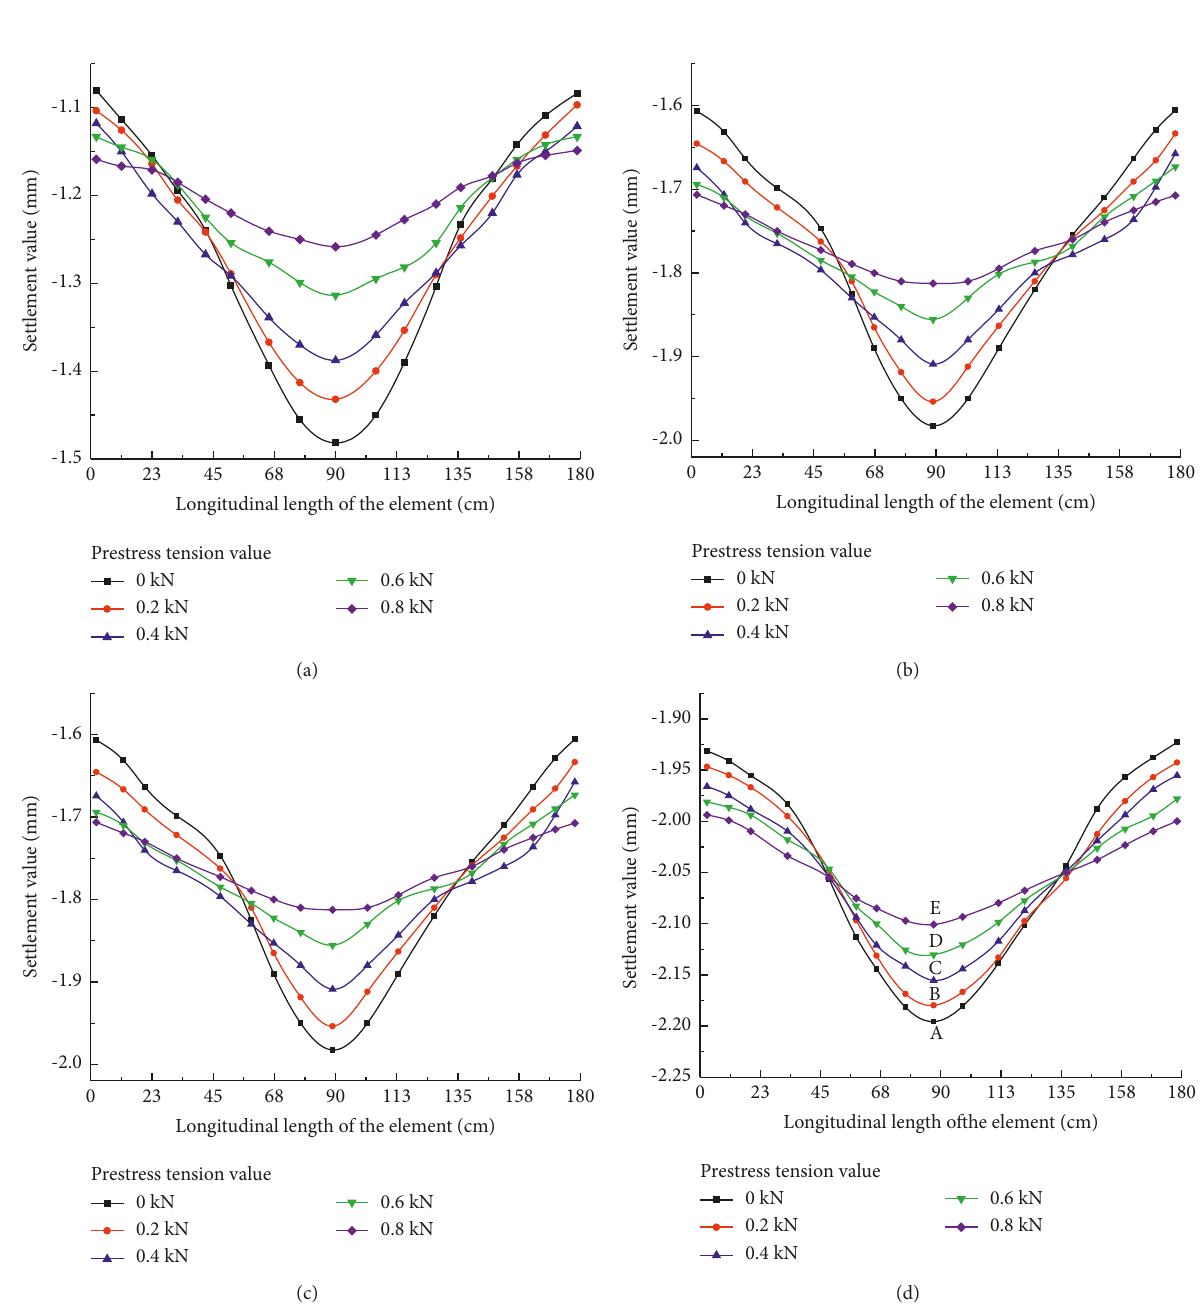
Figure 15: Settlement-load distribution curve: (a) 5 kPa, (b) 10kPa, (c) 15kPa, and (d) 20 kPa.